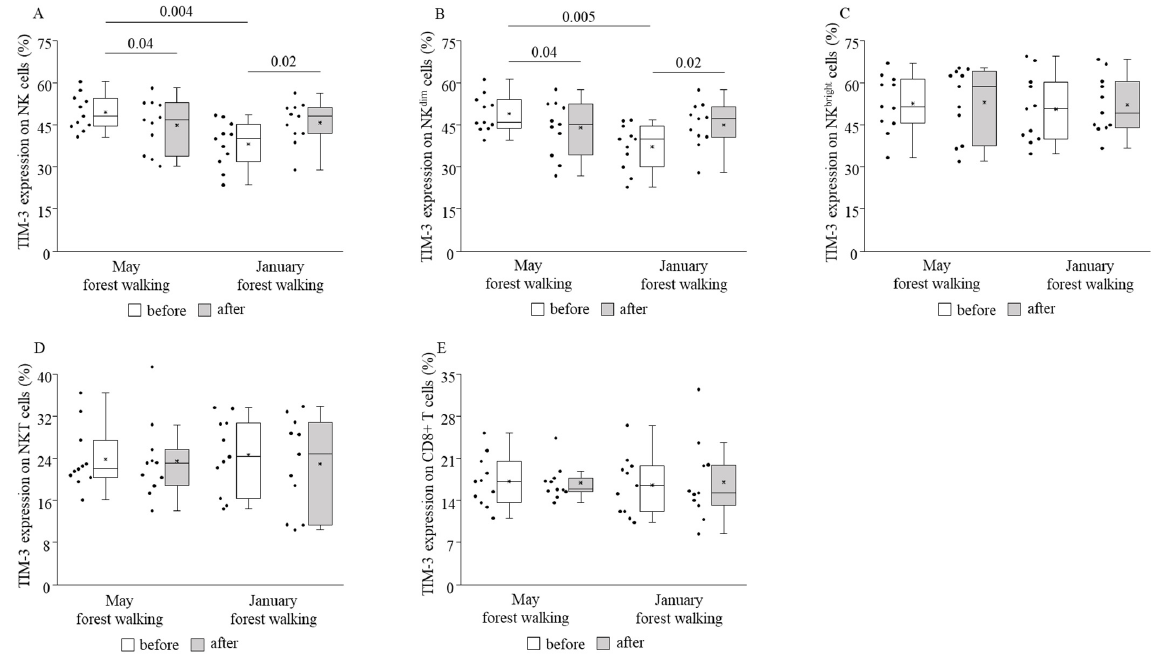
Figure 8. TIM-3 expressions on total NK ( A ), NK dim ( B ), NK bright ( C ), NKT ( D ), and CD8+ T ( E ) cells prior to and following the late spring (May) and winter (January) forest walks. The middle line within the box represents the median, the middle dot within the box represents the mean, the boxes indicate the interquartile ranges between the 25th and 75th percentiles, and the whiskers show the most extreme observations in the box plot. Individual dots left from the boxes represent individual data values. Differences were considered statistically significant for p -values < 0.05. Statistically significant p -values are indicated on the horizontal lines outside the boxes.